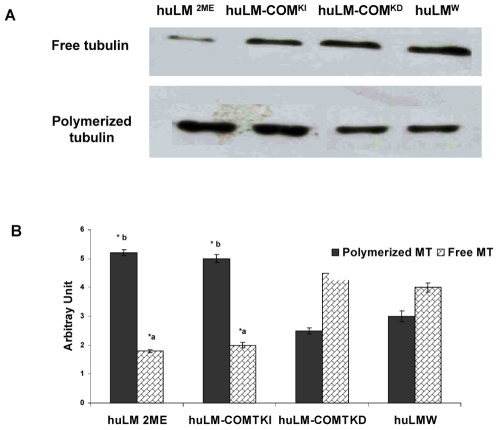
Relative abundance of free and polymerized tubulin in huLM2ME, huLM-COMTKI; huLM-COMTKD and huLMW.(A) Representative gel (30 µg of protein for each sample) displaying free and polymerized tubulin. (B) Graph summarizing data from three independent experiments with levels of free and polymerized tubulin expressed in arbitrary units. *a significantly (P<0.05) lower than huLMW or huLM-COMTKD * b significantly (P<0.05) higher compared with huLMW or huLM-COMTKD.